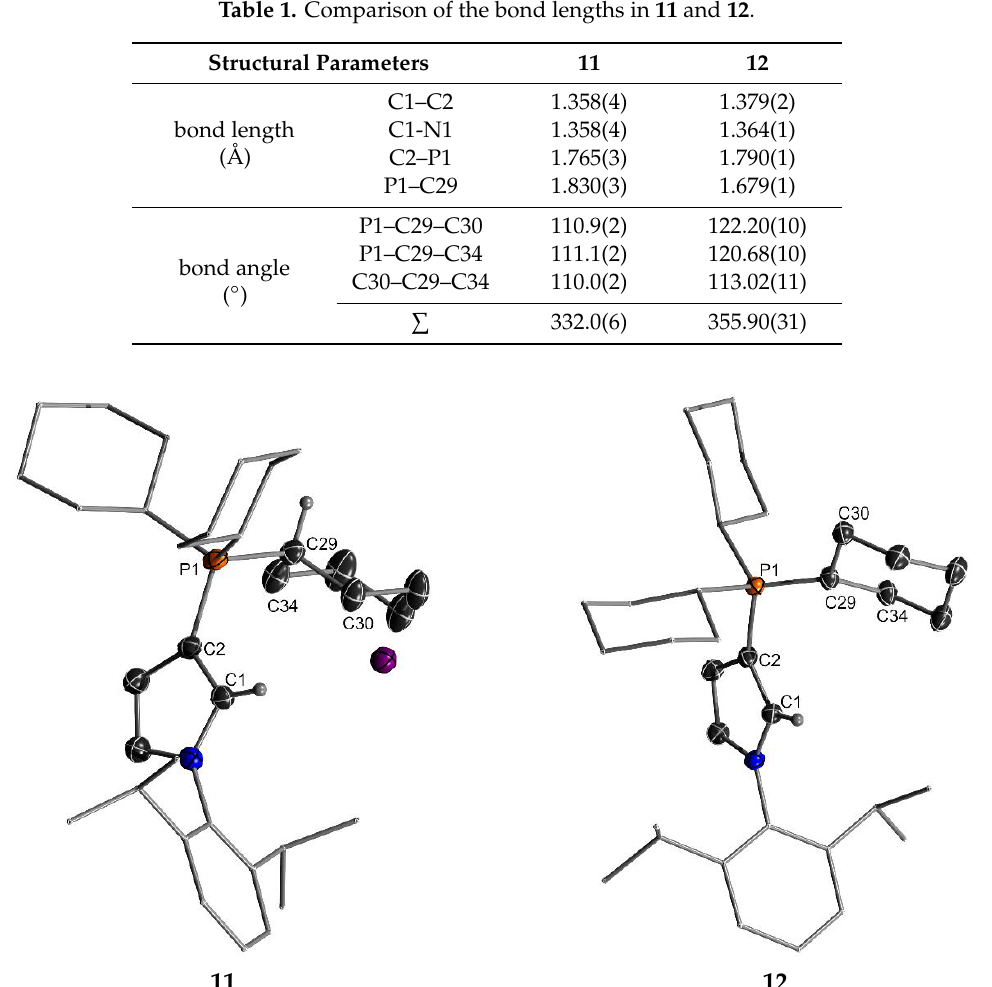
Figure 4. Molecular structures of (left) 11 and (right) 12 . Ellipsoids are drawn at the 50% probability level. Selected bond lengths are provided in Table 1.